Question: Provide a one-line summary of what is displayed.
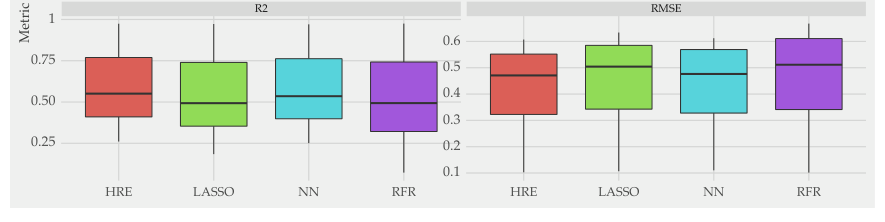
Answer: Distribution of forecasting performance across the forecasting horizon for each regres- sion approach by different metrics.